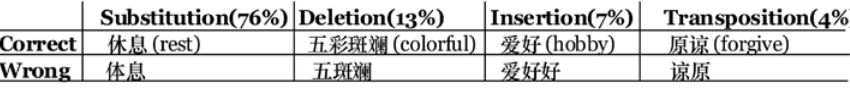
Figure 8: Examples of Four Kinds of Errors with Their Proportions.